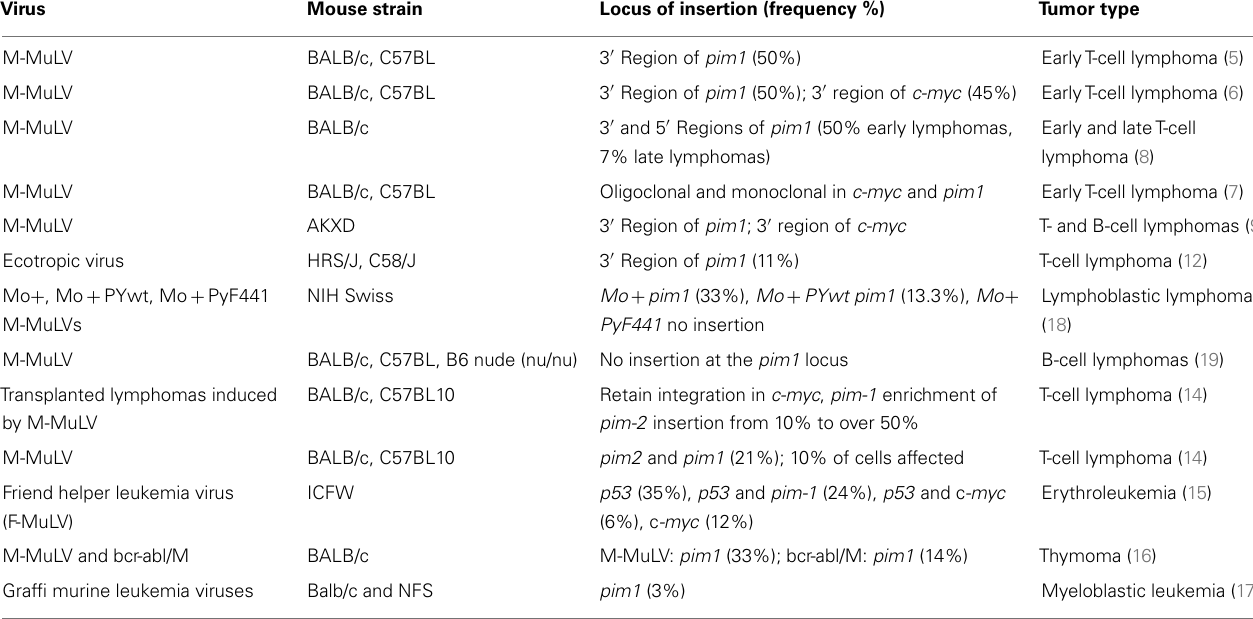
Table 1 | Pim1 as a proviral integration site